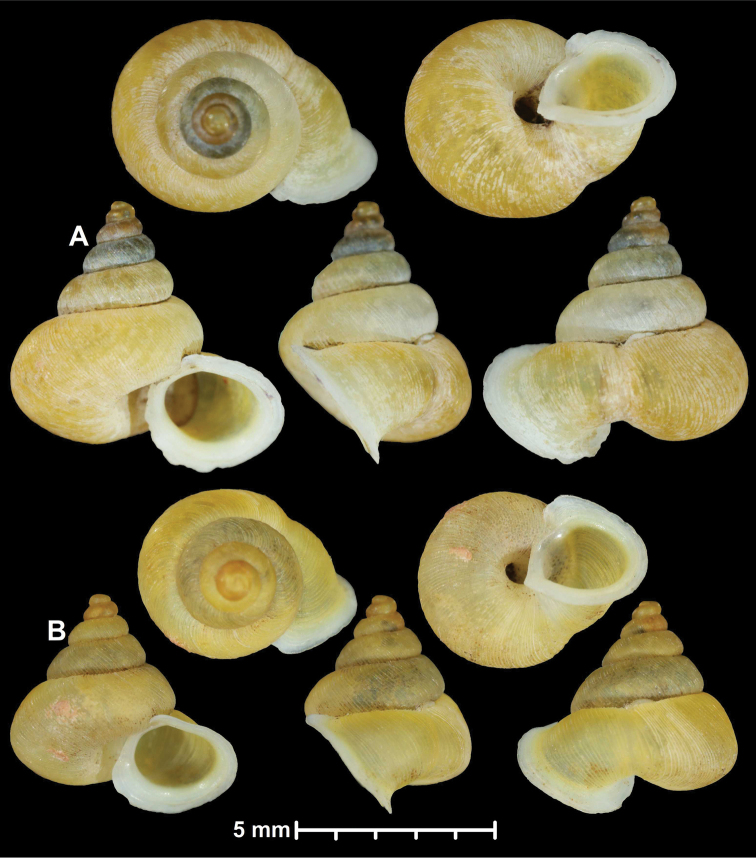
Shells of Stomacosmethis Bollinger, 1918 species AStomacosmethis
fultoni (Möllendorff, 1896), lectotype (SMF 109280) BStomacosmethis
fultoni
degenerans (Fulton, 1901), lectotype (SMF 109282). All figures: Barna Páll-Gergely, courtesy Ronald Janssen.